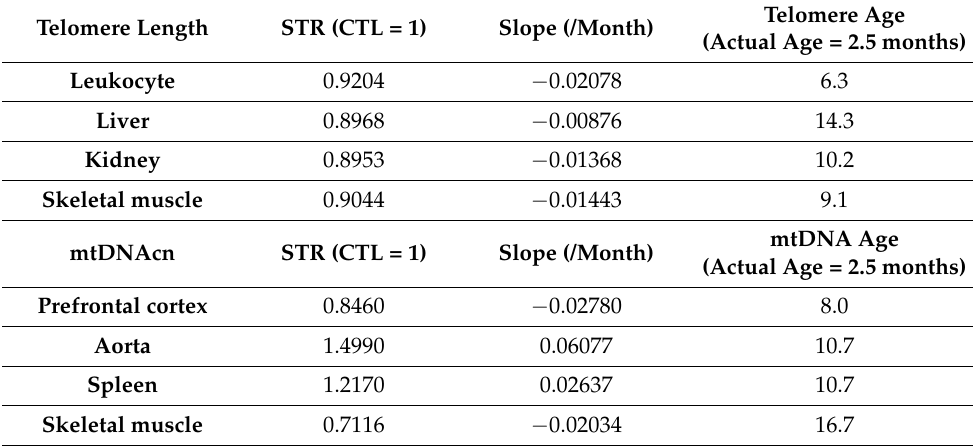
Chronic immobilization stress (CIS)-induced aging acceleration. Telomere age and mitochondrial DNA age of stressed mice (STR) were calculated using the qPCR results (Figure 3) and the slope of the chronological aging standard curves (Figures 1 and 2). The tissues that showed significant changes by both CIS and normal aging are